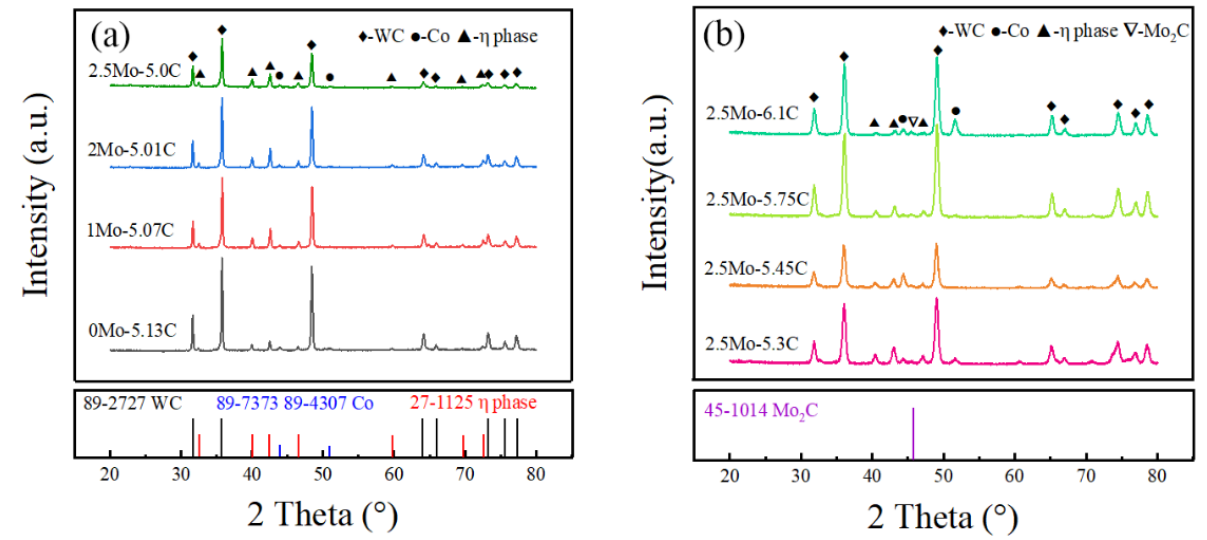
Figure 2. XRD results of WC-13Co alloys with different contents of Mo and C, ( a ) WC-13Co-x%Mo, ( b ) WC-13Co-2.5Mo-x%C. Table 2. Lattice constants of WC and eta phase of various compositions.